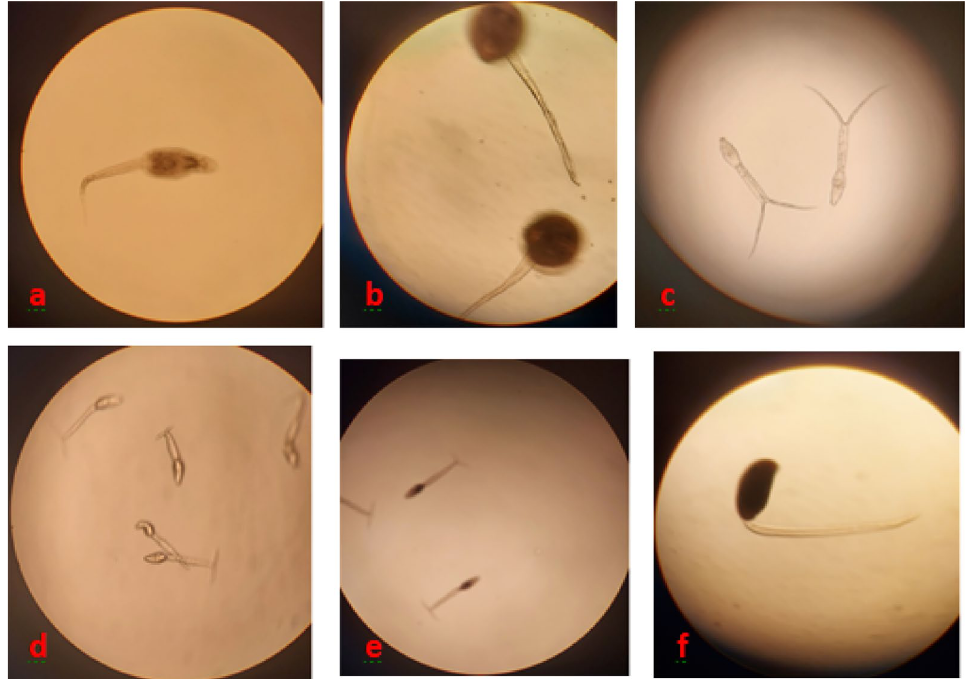
Figure 7. Trematode cercaria shed by Biomphalaria snails 100 × magnification; ( a ) Echinostome cercaria , ( b ) Amphistome cercaria , ( c ) Brevifurcate-apharyngeate diastome cercaria , ( d, e ) Schistosome cercaria, ( f ) Unidentified cercaria. Echinostome and Schistosome cercaria observed from all study sites while Brevifurcate diastome cercariae were observed in Cherechera, Enferanze, Robit and Dek. Unidentified cercaria was observed from Dek Island.